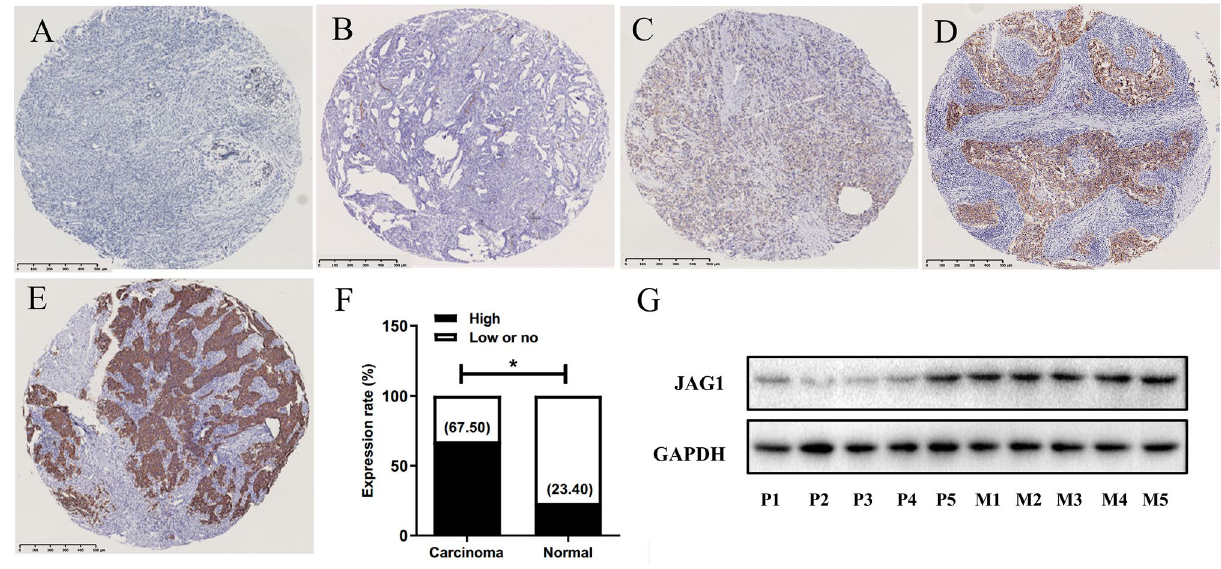
Figure 1. JAG1 protein expression in breast tissues. ( A ) Adjacent breast tissue with no JAG1 expression (IHC score, 0); ( B ) BC tissue with low JAG1 expression (IHC score, 40); ( C ) BC tissue with high JAG1 expression (IHC score, 100); ( D ) BC tissue with high JAG1 expression (IHC score, 160); ( E ) BC tissue with high JAG1 expression (IHC score, 240); ( F ) JAG1 protein expressions in breast tissues; ( G ) JAG1 expression in patients with or without brain metastases. P1–P5, patients without brain metastases. M1–M5, patients with brain metastases. * P <